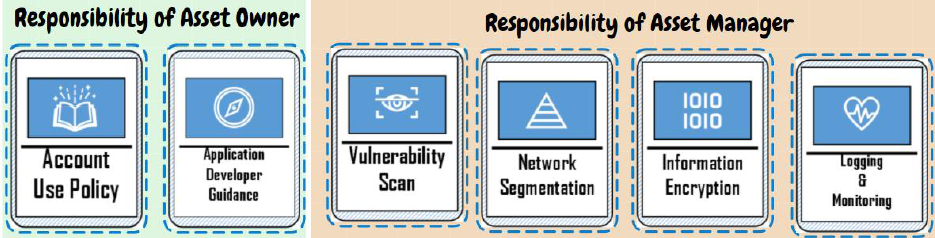
Figure 1. Trial run: a screenshot of the game board on the defender side.